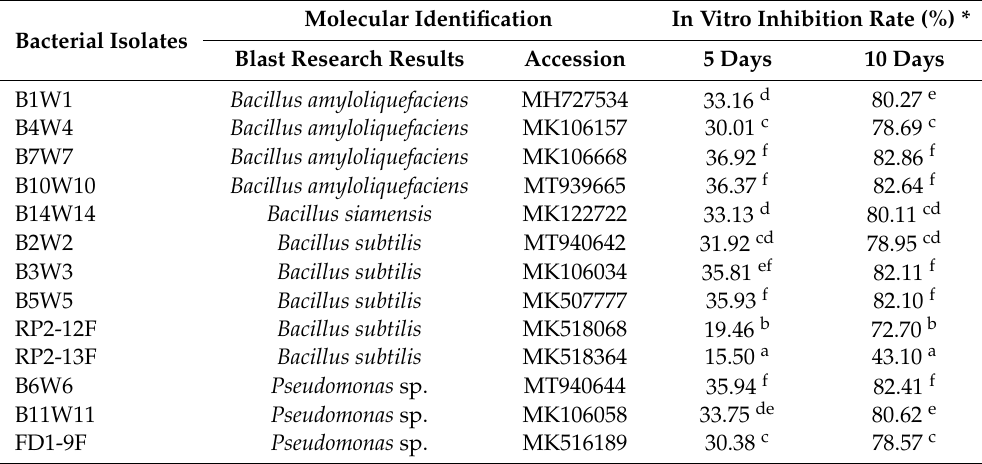
Table 1. Molecular identification of bacterial isolates using subunit 16S rRNA and their potential antagonistic e ff ect on the mycelial growth of the pathogenic fungus Monilinia fructigena under in vitro